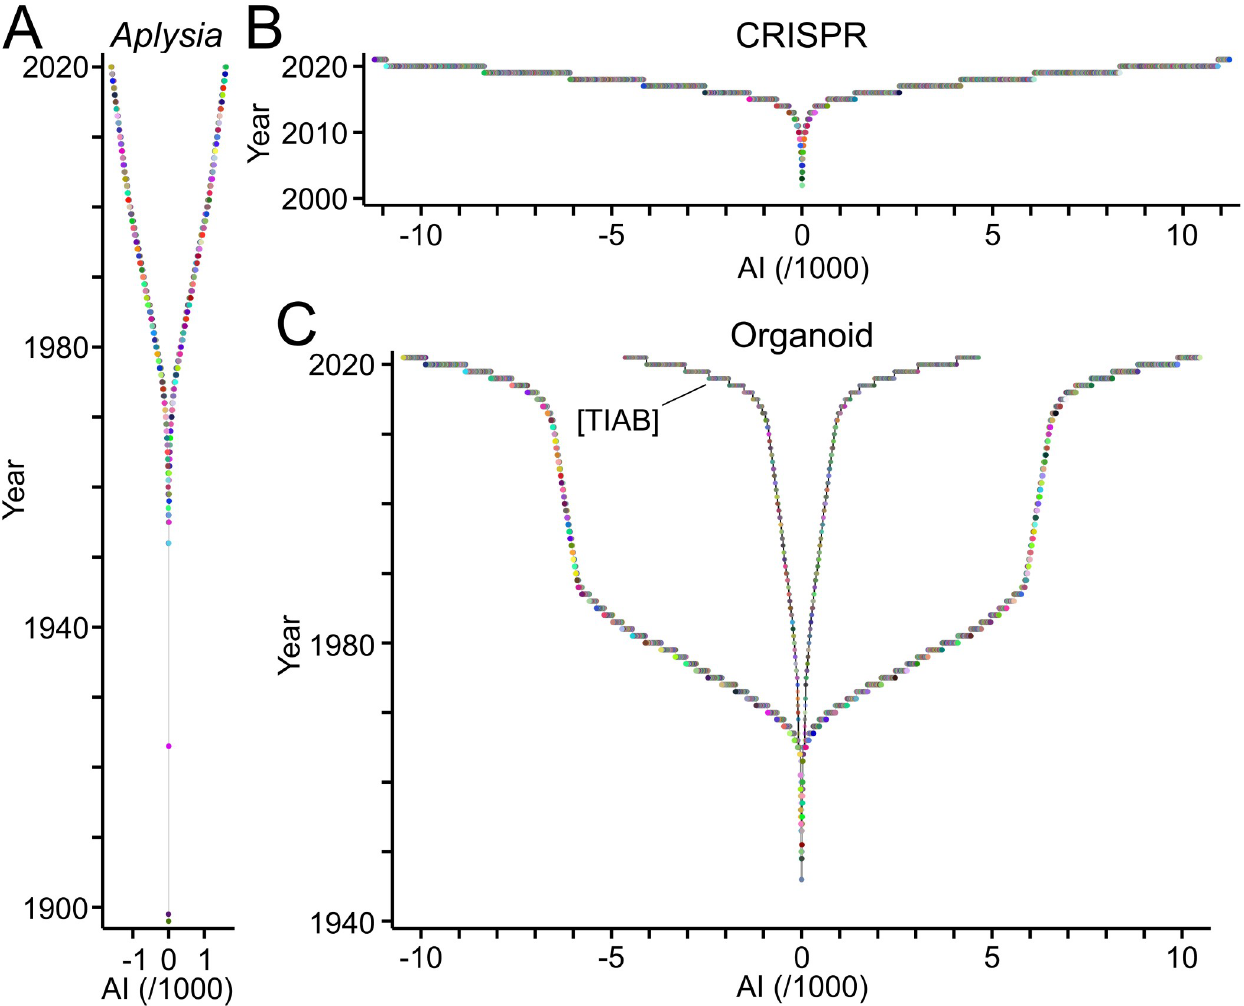
Fig 2. TeamTree graphs showing the development of selected fields of biomedicine. TTGs reveal the distinct duration, growth and size of the workforce publishing scientific articles related to Aplysia (A), CRISPR (B) and organoids (C). Circles represent authors contributing to each field with the year of their first publication as last author plotted against their AI values. Signs of AI values alternate for better accessibility. Note the distinct development of the "organoid" field in panel C when publications were analysed, where the term "organoid � " is mentioned in the title or abstract as indicated by the PubMed field tag